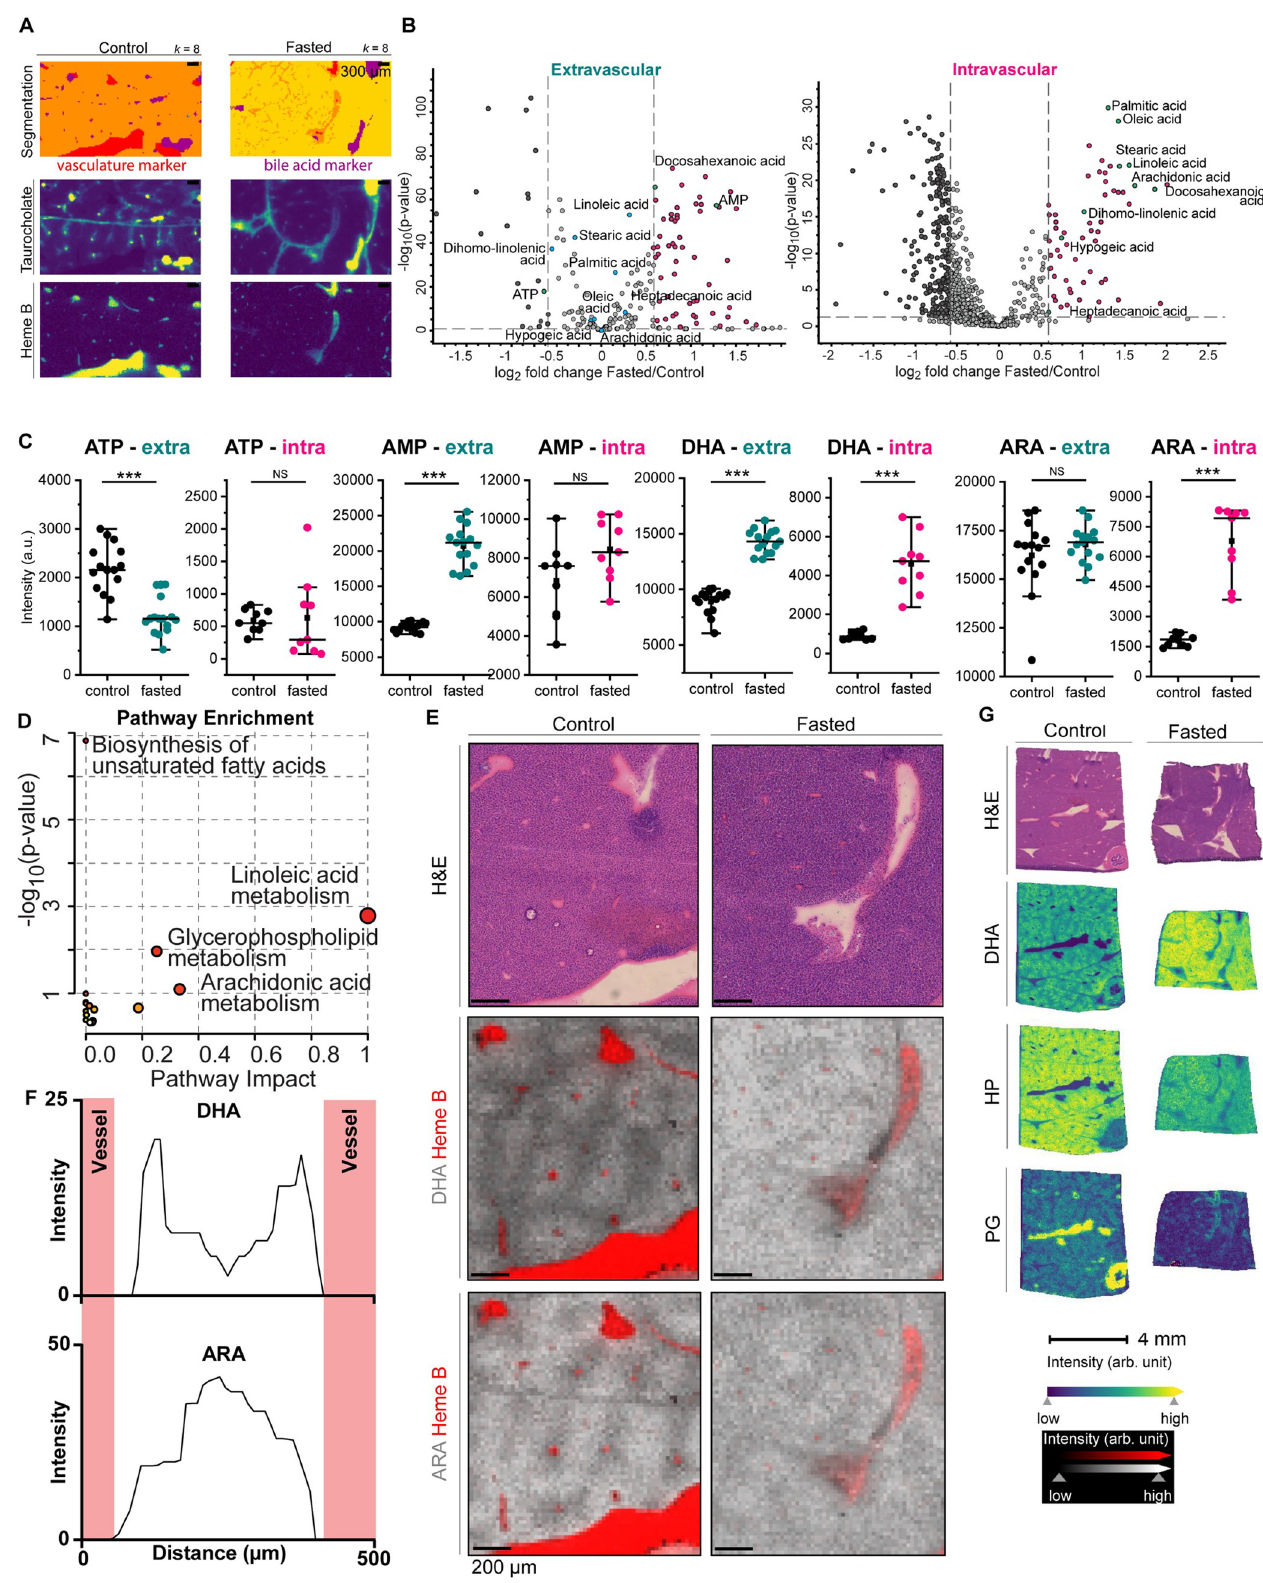
Fig 3. Liver metabolism and fuel switching. (A ) Segmentation map of the MALDI MSI data based on bisecting k-means clustering ( k = 8), where each cluster is represented as an individual color, and MALDI MSI ion images of heme B as a marker of the vasculature corresponding to the red segment and taurocholate as a marker of the bile acids corresponding to the purple segment. Intravascular regions were defined based on the intensity of heme B. (B) PLOS ONE | https://doi.org/10.1371/journal.pone.0261803 September 6,